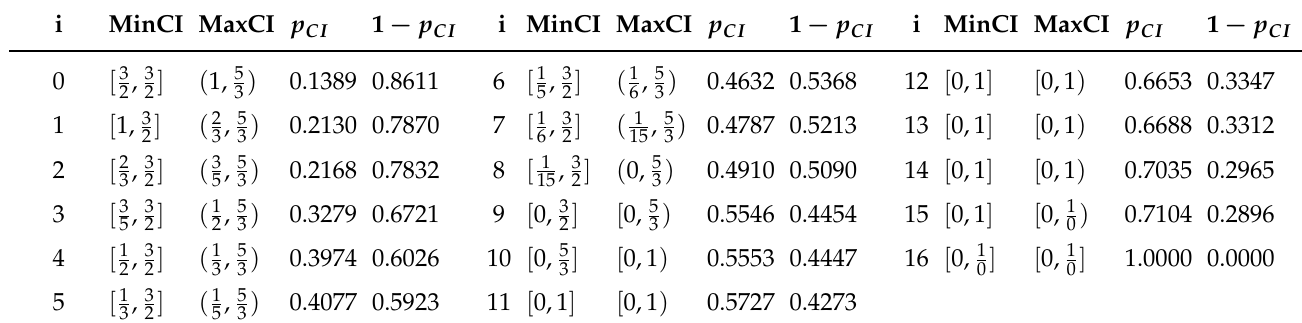
Table A7. Confidence intervals in increasing coverage for OR (data from Table A5).